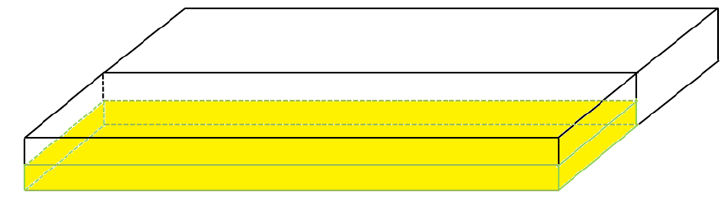
Figure 3. The computational domain for residual stresses represented with yellow color.